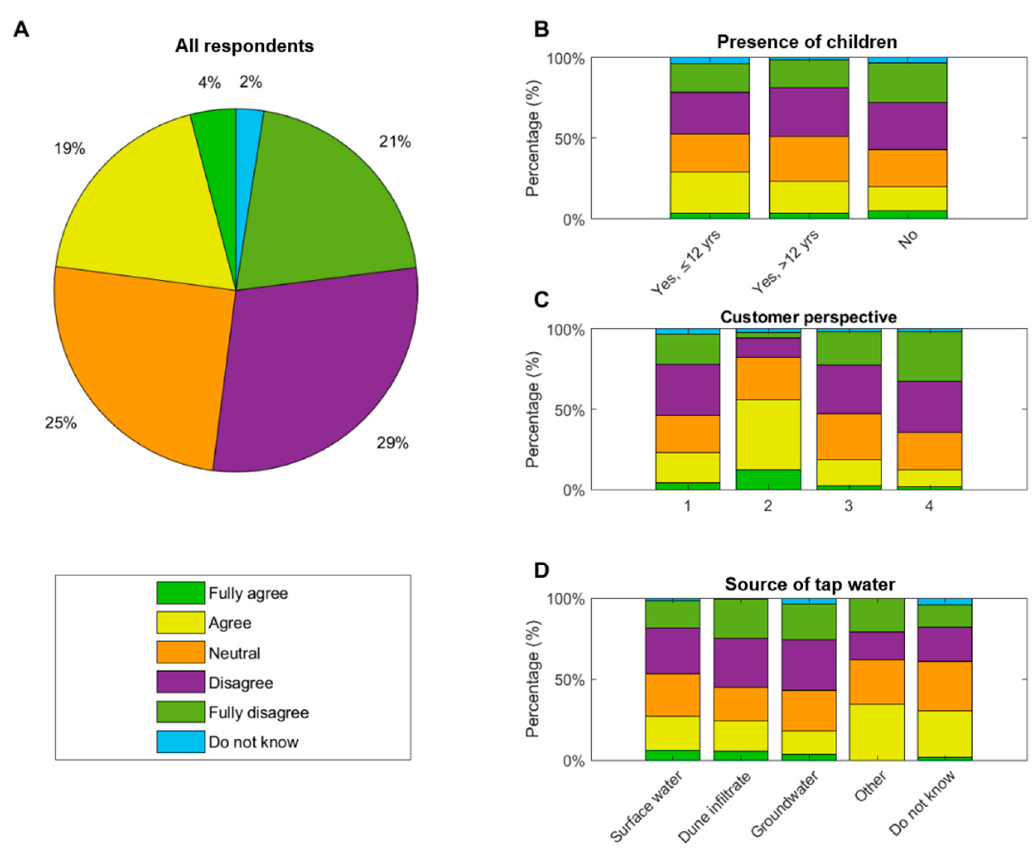
Figure 1. Level of agreement with the statement: ‘I sometimes have concerns about the quality and safety of Dutch tap water’. Graph ( A ): For all people questioned. Graph ( B ): How the presence of children affects the water quality concerns. Graph ( C ): How the customer perspectives affect water quality concerns (1 “aware and committed”; 2 “quality and health concerned”; 3 “egalitarian and solidary”; and 4 “down to earth and confident”). Graph ( D ): How knowledge on the source of tap water may affect the water quality concerns of customers.